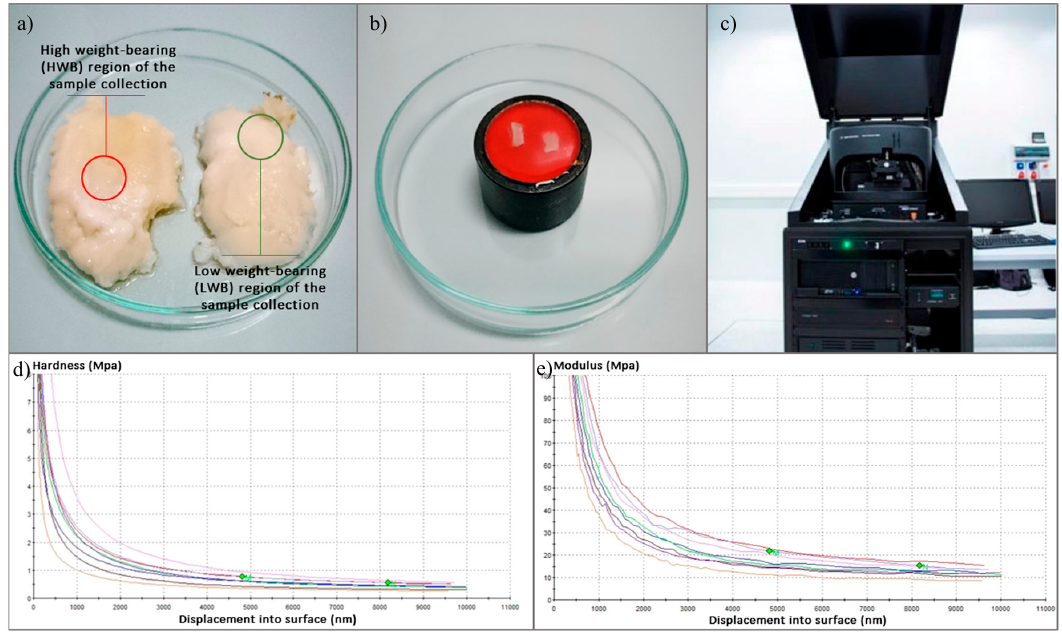
Figure 1. Graphical description of the experiment design: ( a ) indication of locations chosen for sample harvesting; ( b ) sample prepared for measurement; ( c ) nanoindenter used in the study; ( d , e ) exemplary data obtained from the measurements.